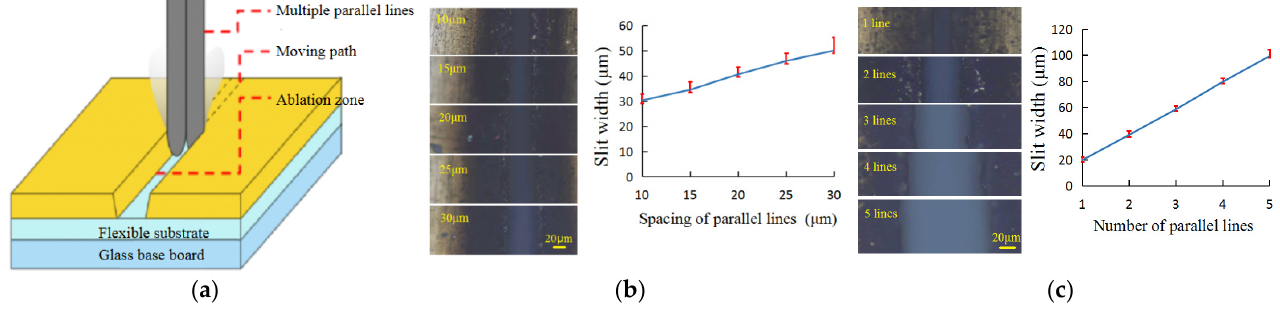
Figure 7. ( a ) Schematic diagram of multiple parallel line cutting. ( b ) Variation of slit width with spacing of parallel lines; ( c ) variation of slit width with number of parallel lines.